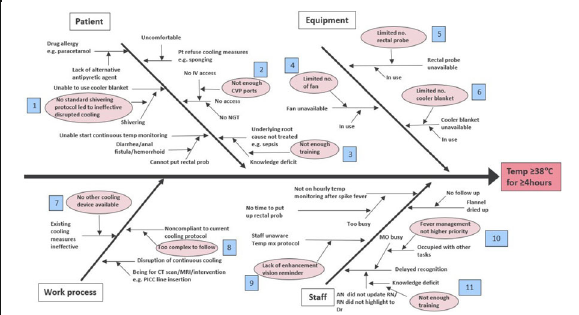
Fig. 2 (abstract 000598). See text for description